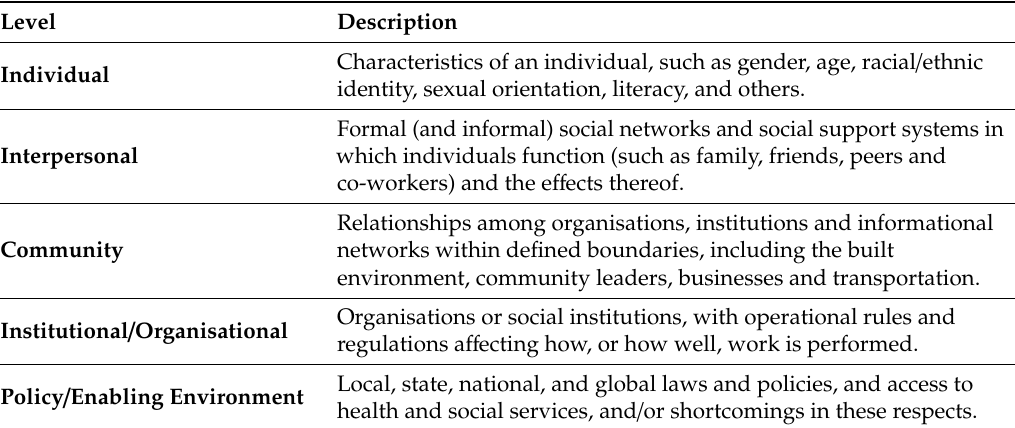
Table 1. Description of levels in the socio-ecological